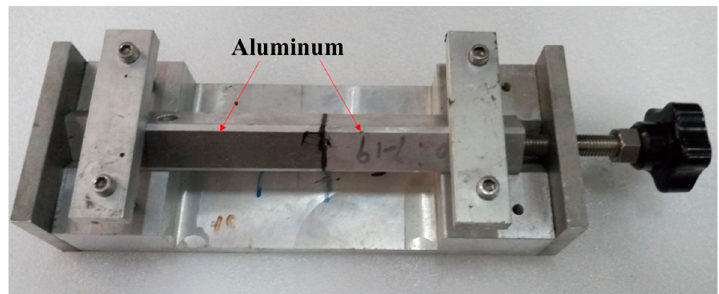
Figure 5. Adhesion fixture for docking and scarf specimens.